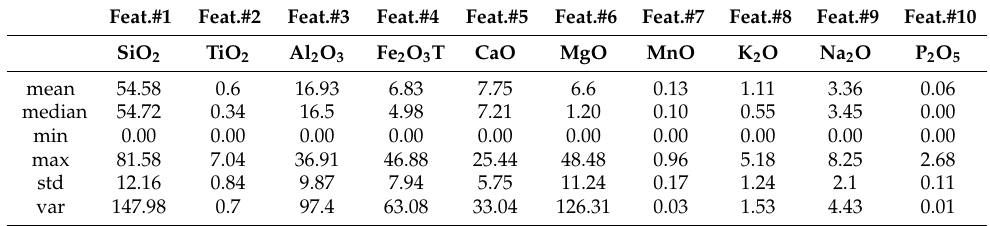
Table 6. Basic statistics of Dataset 4.